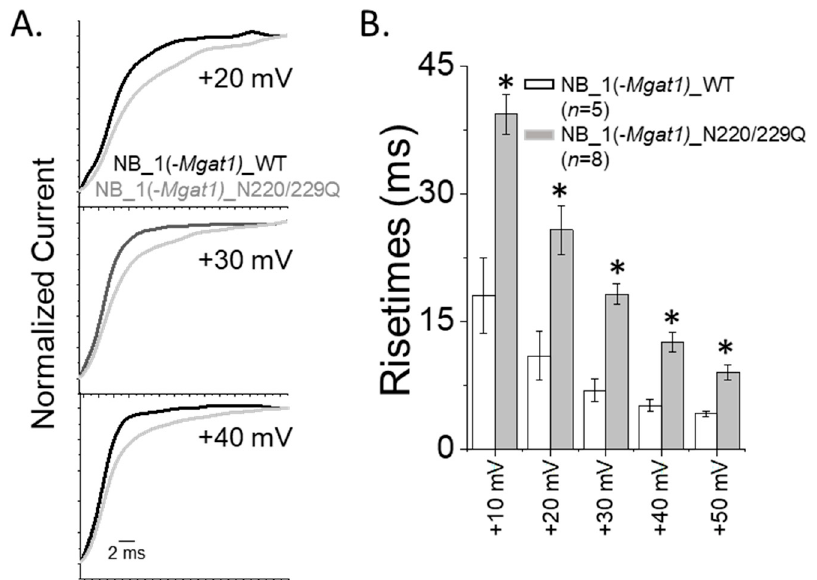
Figure 7. Delayed opening rates of inactivating currents with altered N-glycan branching. ( A ) Whole cell currents of inactivating current were expanded for NB_1( -Mgat1 )_WT and NB_1( -Mgat1 )_DM cells lines. ( B ) Rise times obtained from inactivating currents of NB_1( -Mgat1 )_WT and NB_1( -Mgat1 )_DM expressing cells. Data are presented as the mean ± SEM and were compared by Student’s t-test (* p < 0.05).